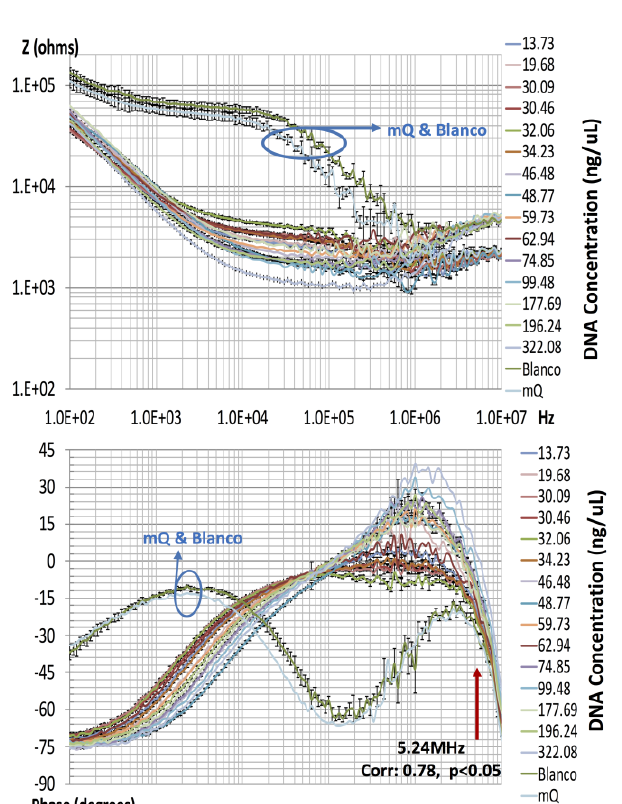
Fig.3: The EBiS of the DNA samples are portrayed in magnitude and phase. The values are expressed as the mean and standard error of measurements taken in triplicate. The spectra for the reference and miliQ water, included in the graph, were used as clean vehicles for DNA absorbance and EBiS measurements, respectively.